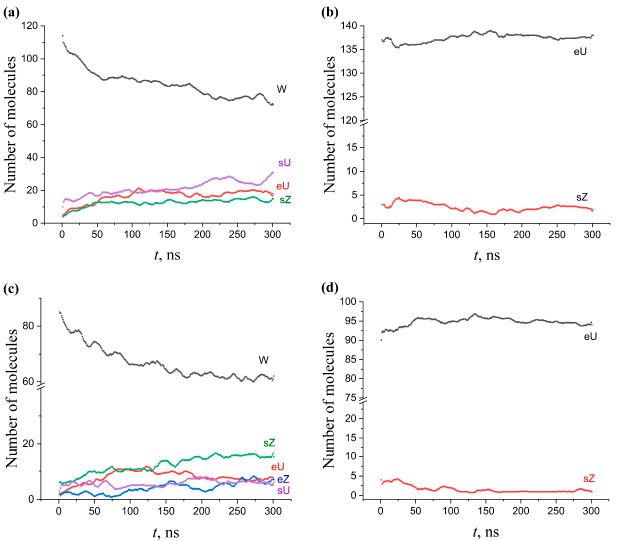
Figure 7. Conformational changes for AMA in the multicomponent AMA–KMA–MMA membranes during 300 ns MD. ( a ) Mixed W–W–W membrane with ratio of components 70:15:15. ( b ) Mixed eU–W–W membrane with ratio of components 70:15:15. ( c ) Mixed W–W–W membrane with ratio of components 50:25:25. ( d ) Mixed eU–W–W membrane with ratio of components